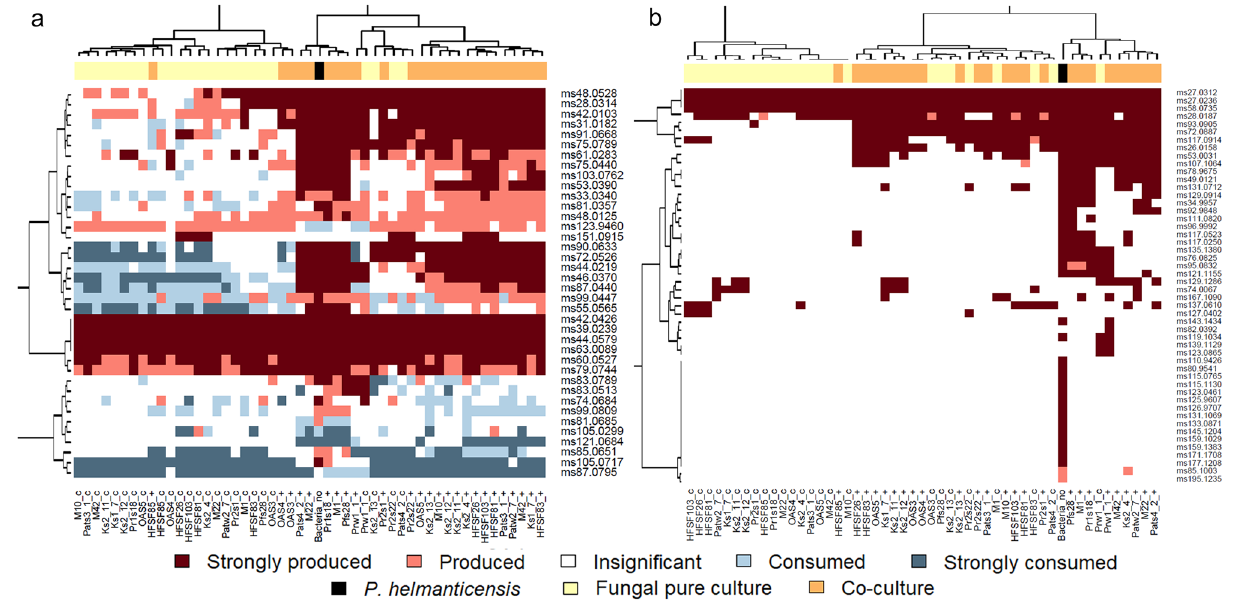
Figure 4. The production/consumption of volatile organic compounds (VOCs; rows) by pure fungal strains and pure Pseudomonas helmanticensis, as well as by their respective co-cultures (columns). A VOC detection limit of 0.2 ppbV was set. Both heatmaps visualise the mean VOC concentrations of the sample groups relative to the VOC concentration measured in PDA. ( a ) VOCs produced by PDA medium. The concentration in the respective sample group can be comparable to PDA, higher than PDA (production) or lower than PDA (consumption). ( b ) VOCs undetected in PDA medium. These VOCs were produced exclusively by the cultures. Production/Consumption of all VOCs indicated by colour was significant compared to PDA medium ( p < 0.05). Strong production/consumption means that the respective VOC’s concentration was more than twofold higher/ lower compared to its concentration measured for PDA medium.